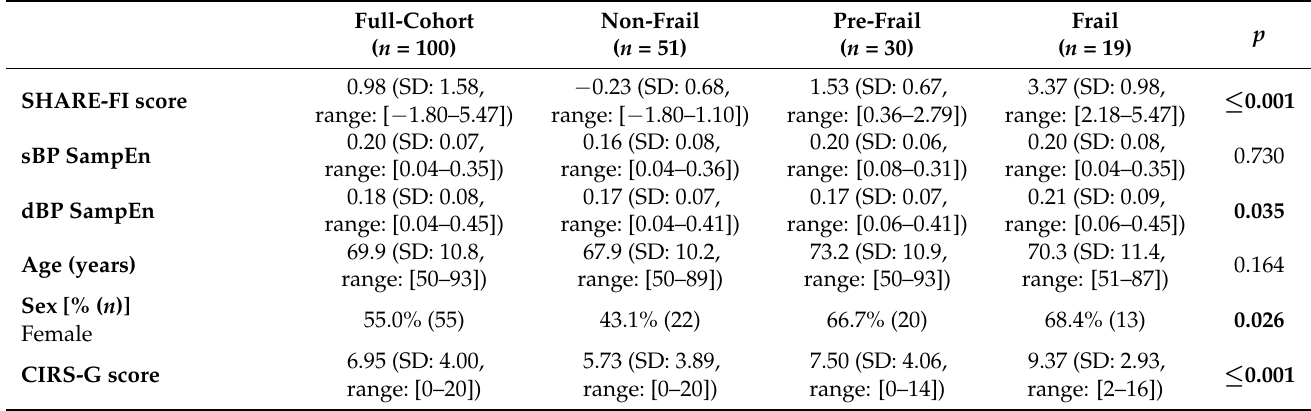
Table 1. Characteristics of the study sample. Continuous variables are reported as the mean value, with standard deviation (SD) and ranges. Dichotomous variables are reported as count and per- centage. p -values are given for the differences between non-frail, pre-frail, and frail groups, from Spearman’s rank correlation coefficients (continuous variables) and chi-square for trend tests (di- chotomous